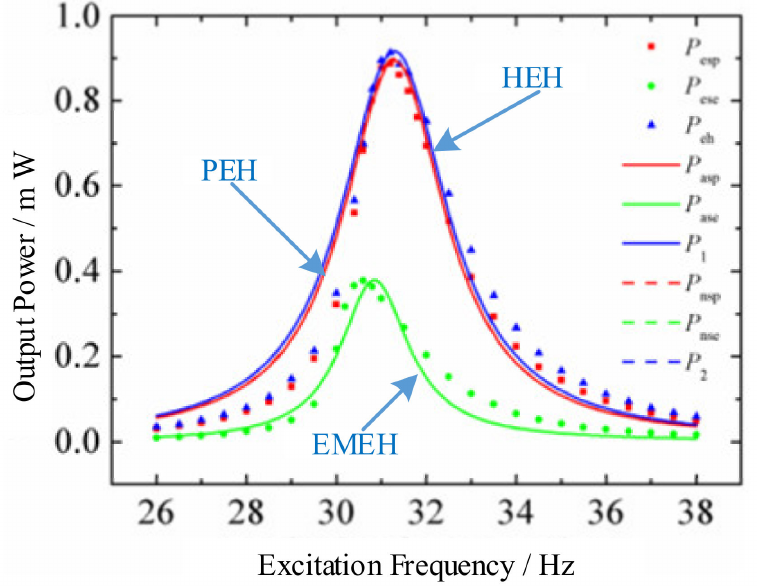
Figure 17. The optimal output power of the stand-alone piezoelectric energy harvester (PEH), stand- alone electromagnetic energy harvester (EMEH), and hybrid energy harvester (HEH) at different excitation frequencies (reproduced with permission from [205]; published by MDPI,